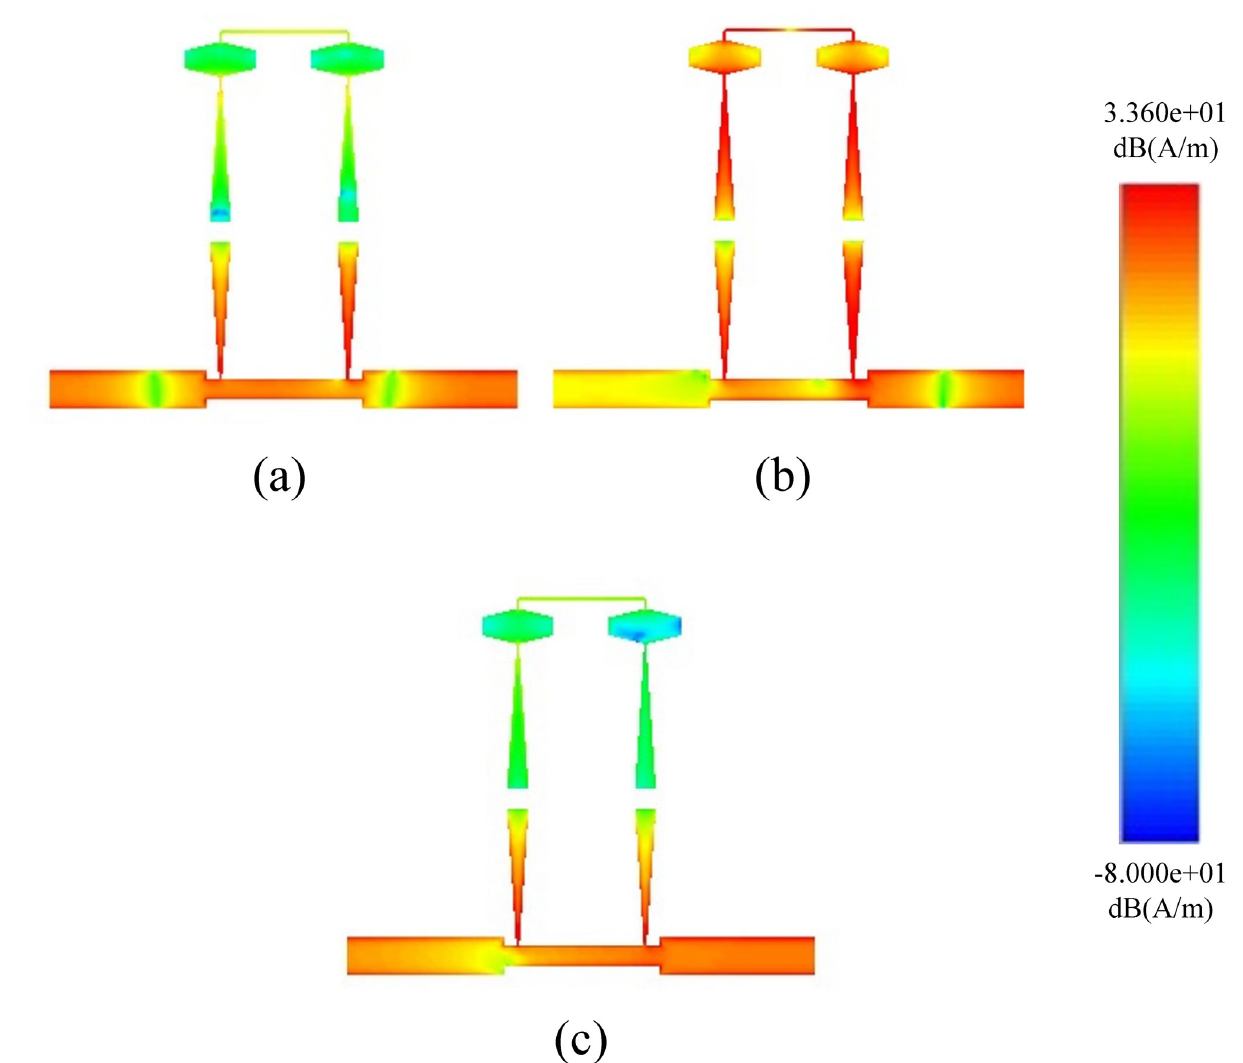
Fig 10. Current distribution of single order